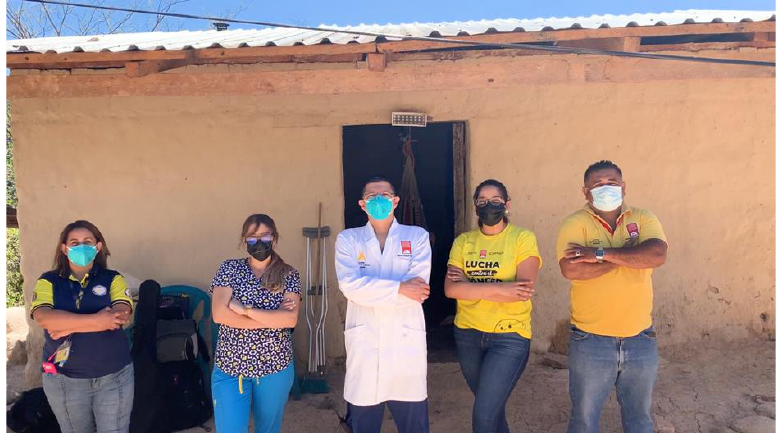
Figure 3. PPC Team on a home visit in